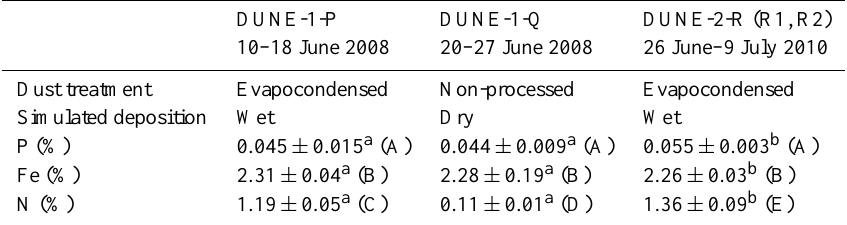
Table 1. Particulate P, Fe and N (%, in weight) in the EC and non-EC dust used during DUNE (from Ridame et al., 2013). Means that were not significantly different for a given chemical element between the different experiments ( p > 0 . 05) are labeled with the same letter (in